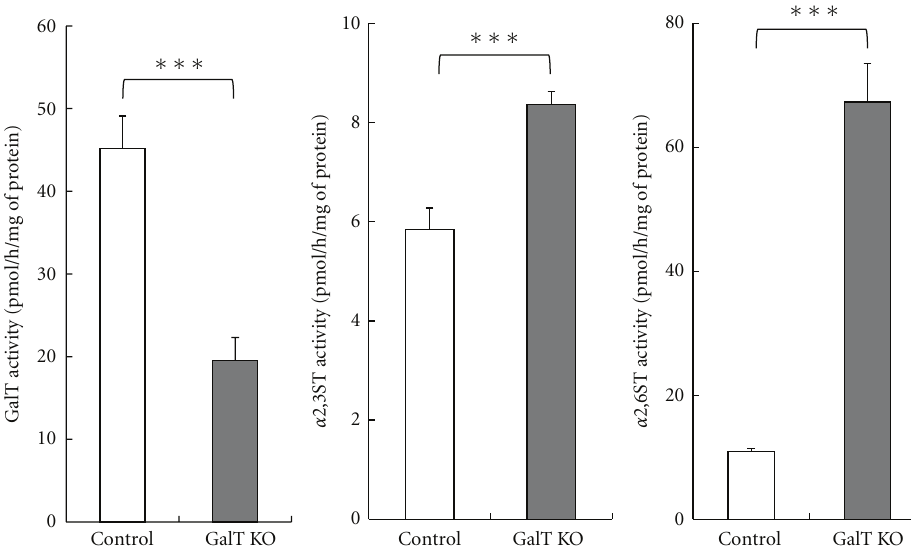
Figure 2: Comparison of α 1,3-galactosyltransferase (GalT), α 2,3- and α 2,6-sialyltransferase ( α 2,3ST and α 2,6ST) activity between control and heterozygote GalT KO liver. From left, GalT, α 2,3ST, and α 2,6ST activity. Each value is the mean ± standard deviation (SD) of triplicate determinations. ∗∗∗ P < 0 .